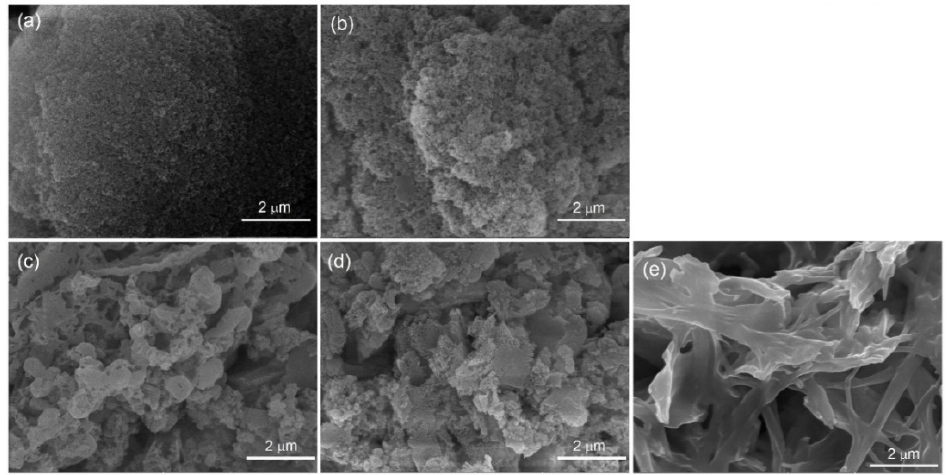
Figure 5. FE − SEM images of ( a ) SiO 2 , ( b ) SnP@SiO 2 , ( c ) MCM − 41, ( d ) SnP@MCM − 41 , and ( e ) SnP .